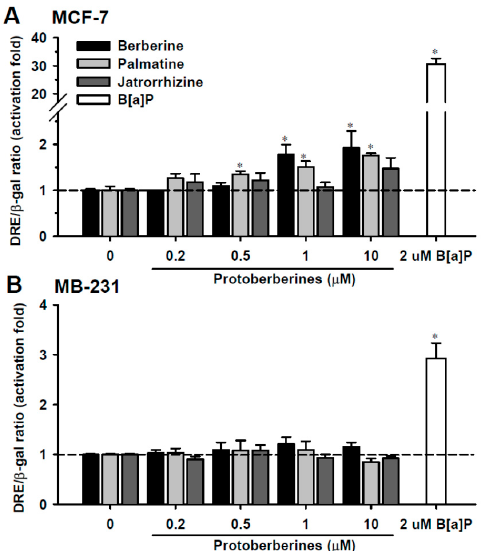
Figure 1. The dioxin-responsive element (DRE) activation by benzo(a)pyrene (B(a)P) and protoberberines in MCF-7 ( A ) and MB-231 ( B ) cells. After transfection of the DRE reporter construct, cells were exposed to B(a)P and protoberberines for 24 h. The DRE reporter luciferase activity was normalized by β -galactosidase activity. Data represent the mean ± SD of 3 separate experiments with 3 determinations for each experiment. * p < 0.05, compared with the control cells.